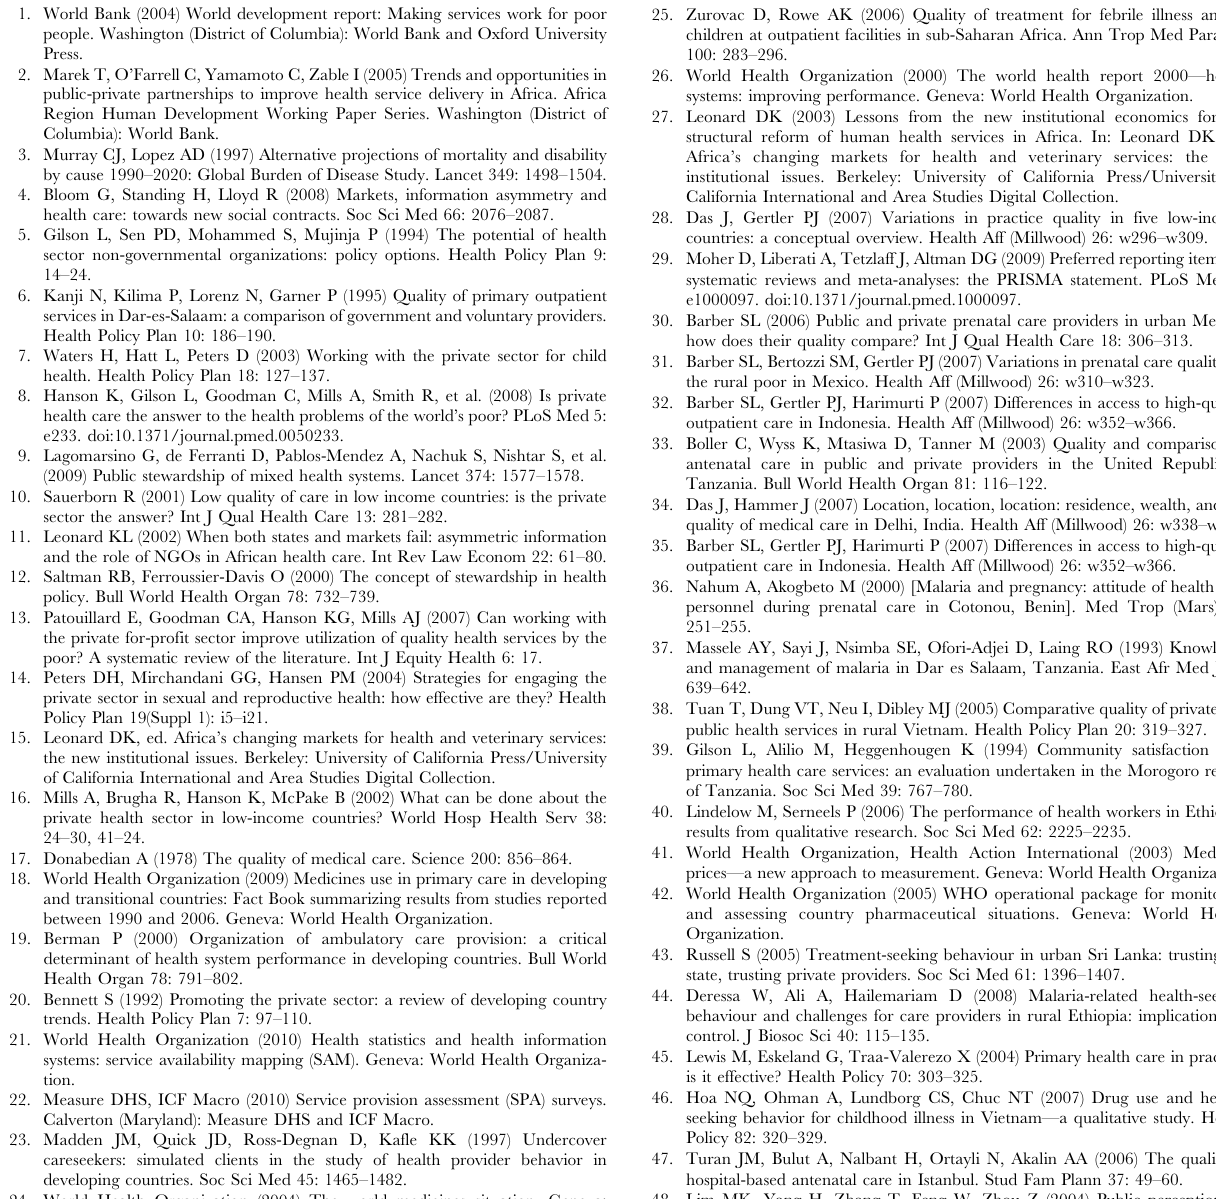
Table S7 Results of comparisons between public and private providers for sub-Saharan Africa only and stratified by private provider type.